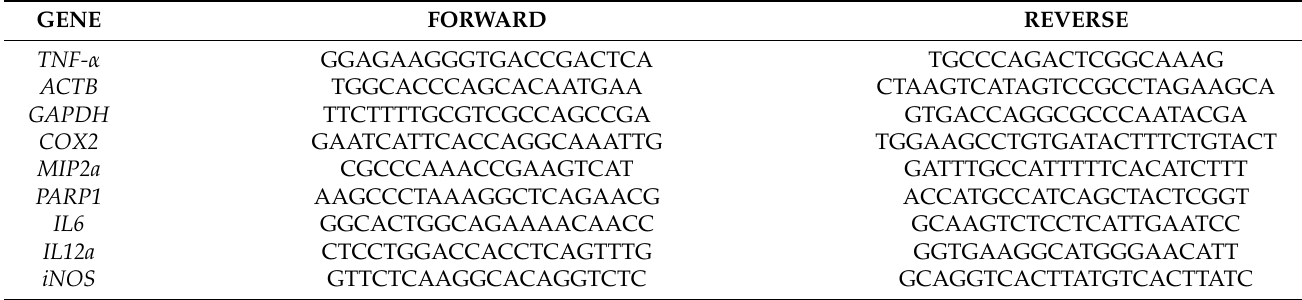
Table 1. Sequences (5 (cid:48) –3 (cid:48) ) of primers